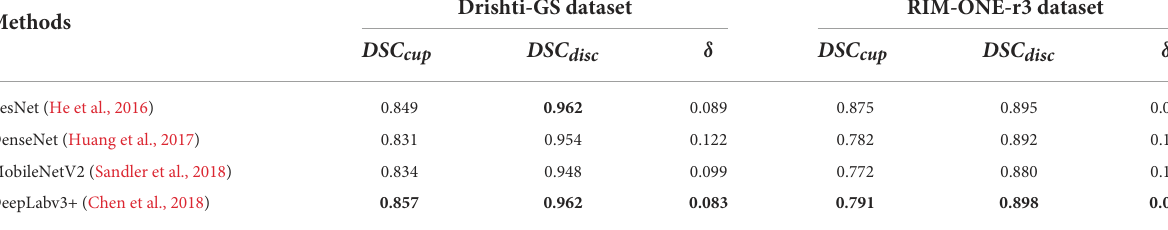
TABLE 6 Comparison of ResNet, DenseNet, MobileNetV2, and DeepLabv3+ as